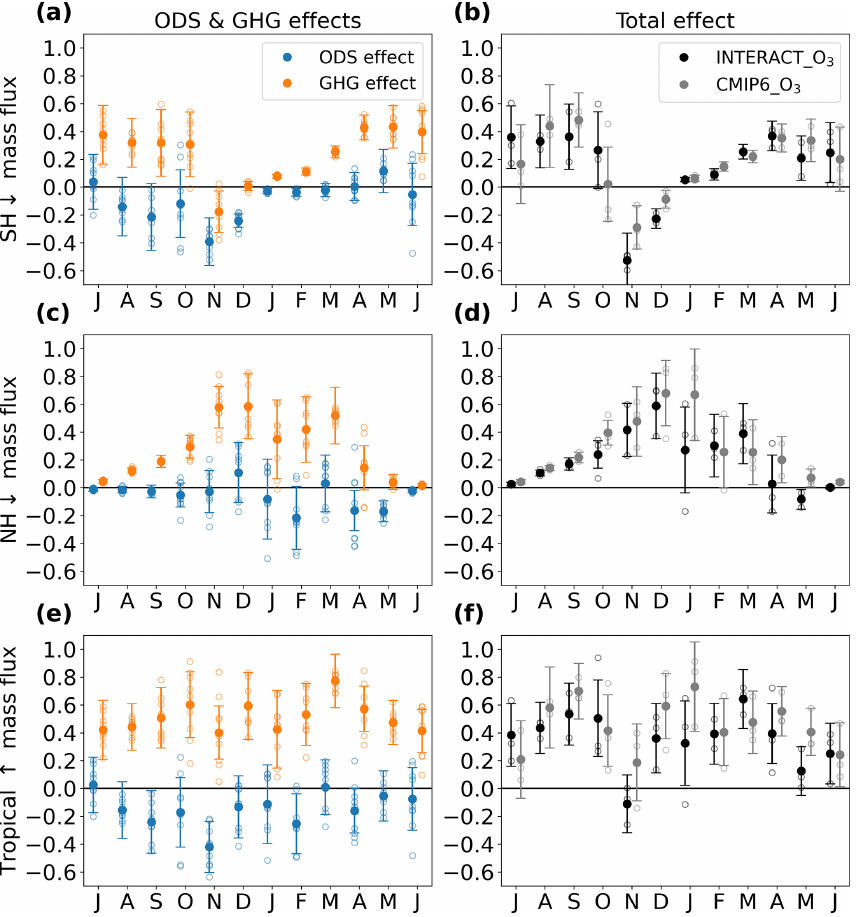
Figure 10. Changes in the SH downward mass flux (a, b) , NH downward mass flux (c, d) , and tropical upward mass flux (e, f) at 50hPa for each month (10 9 kgs − 1 ). The changes due to ozone recovery are shown in blue, the changes due to GHGs are shown in orange (a, c, e) , the total changes in INTERACT_O 3 are shown in black, and the total changes in CMIP6_O 3 are shown in gray (b, d, f) . The error bars give the 95% confidence interval based on a two-tailed t test. Differences between ensemble means are depicted by filled circles, and differences between individual simulations are depicted by hollow